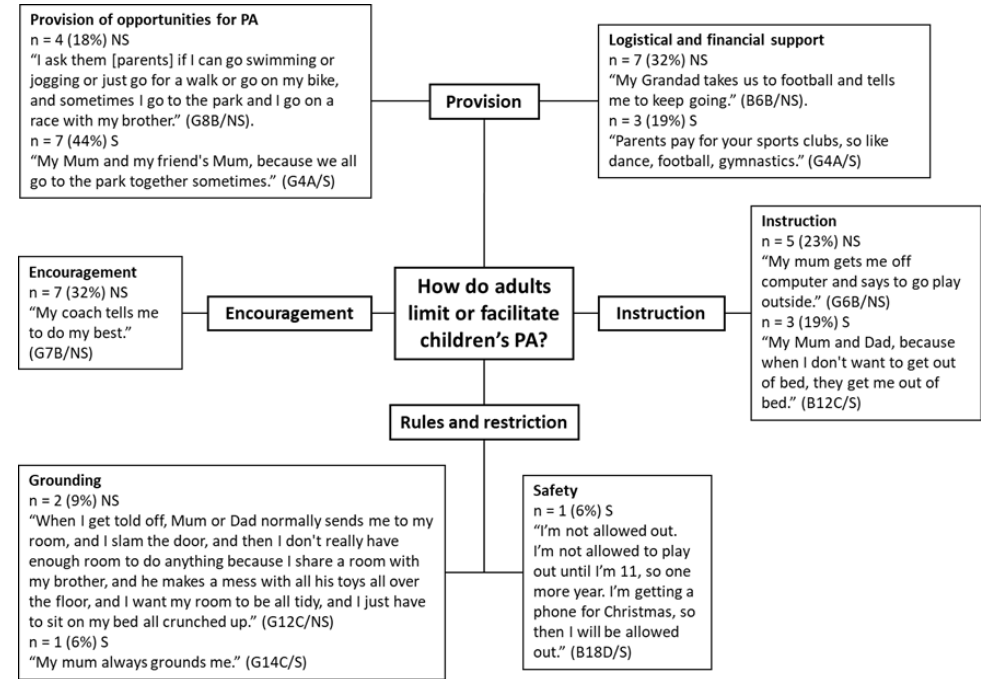
Figure 6. Pen profile demonstrating how adults limit or facilitate a child’s ability to be physically active according to children from non-smoking (NS) and smoking (S) homes. Percentages represent the proportion of each group that contributed to the theme for children from smoking ( n = 16) and non-smoking homes ( n = 22).